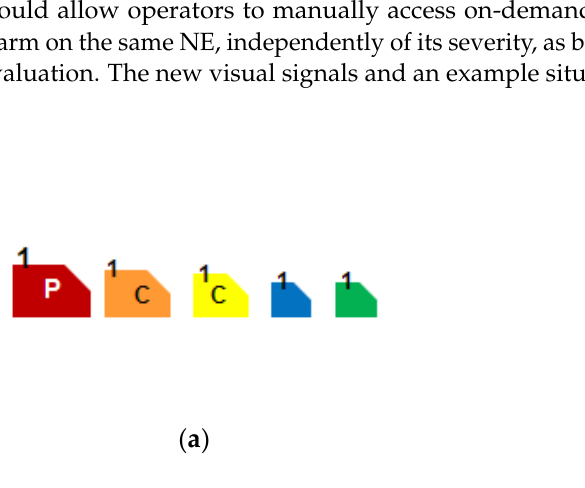
Figure 8. Redefinition of multiple fault information in the detailed component: ( a ) The new intra-NE simultaneous alarms signals (color, size, and LOD depends on the severity level) and ( b ) an example configuration of a hybrid